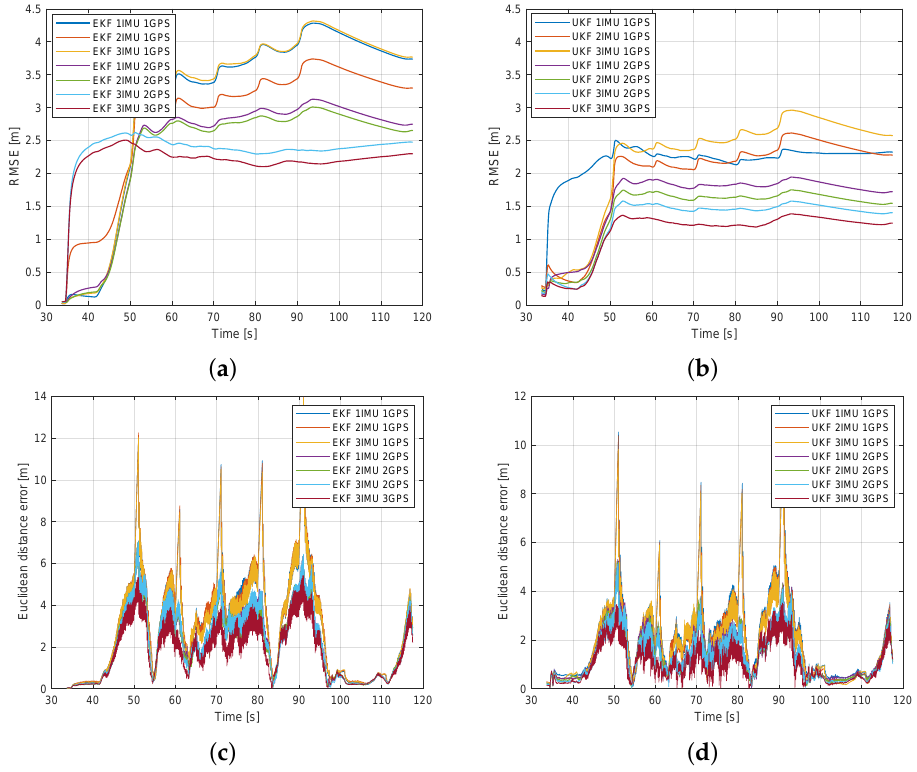
Figure 8. Quantitative evaluation of different methods. Here ( a ) RMSE of EKF and ( b ) RMSE of UKF show the accumulative error, i.e., RMSE, while ( c ) Euclidean distance error of EKF and ( d ) Euclidean distance error of UKF demonstrate the current Euclidean distance error of each sensor arrangement. There are some noticeable instantaneous position changes every ten seconds due to infrequent GPS signal loss. Generally, UKF shows better performance than EKF for both RMSE and Euclidean distance